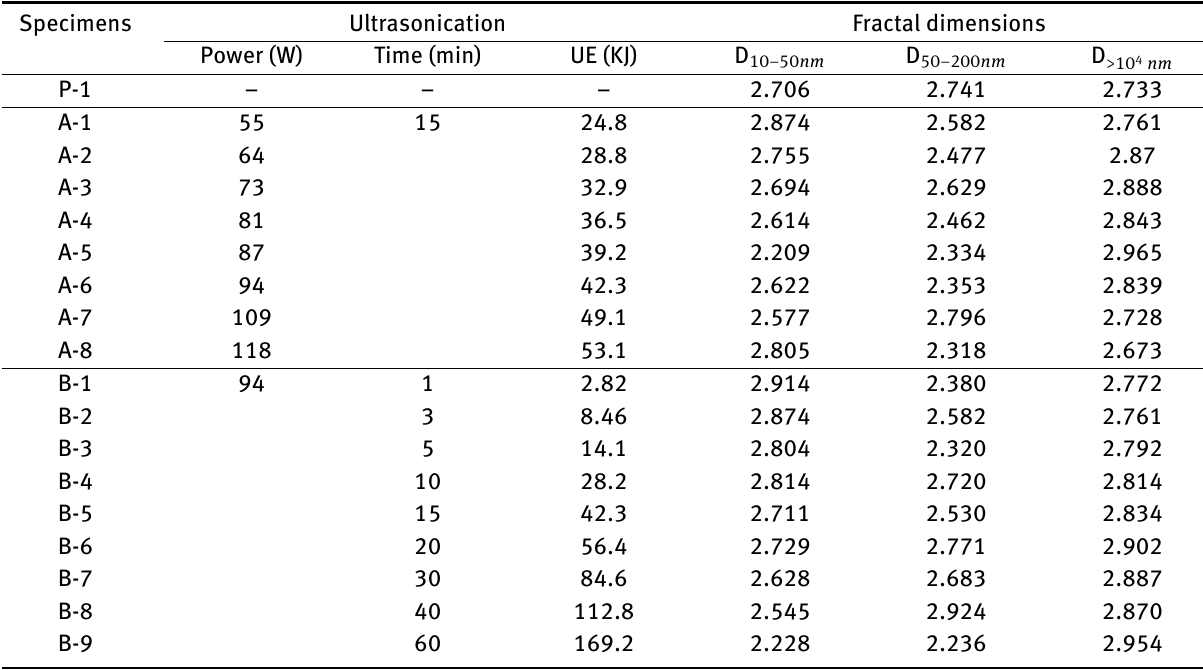
Table 5: Mercury intrusion porosimetry analysis of GO/MWCNT-OPC pastes.